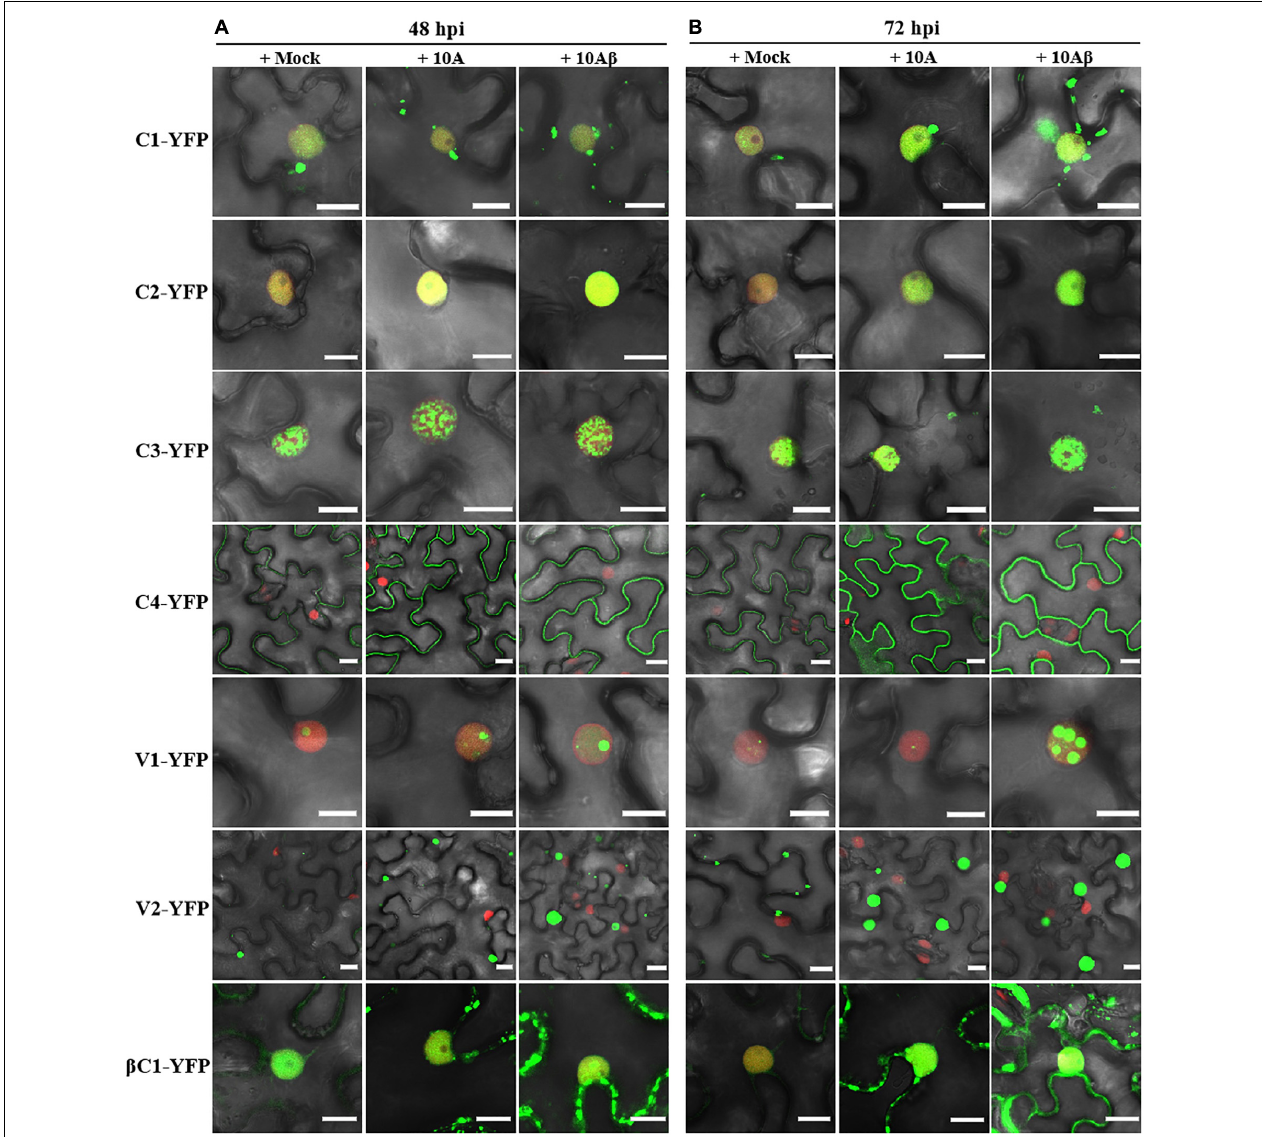
FIGURE 4 | Confocal images of viral proteins fused with YFP in the presence or absence of TYLCCNV (10A), or TYLCCNV/TYLCCNB (10A β ). (A,B) RFP-H2B N. benthamiana leaves were co-infiltrated with Agrobacterium cultures carrying the indicated constructs, and then examined by confocal microscopy at 48 hpi (A) and 72 hpi (B) . All Agrobacterium cultures were adjusted to an optical density at 600 nm (OD600) = 0.8 and 0.5 ml of Agrobacterium cultures were infiltrated into leaves. These experiments were repeated three times by three independent infiltrations, and more than 20 cells per sample were observed in each replicate; representative results are shown. Scale bar: 10 µ